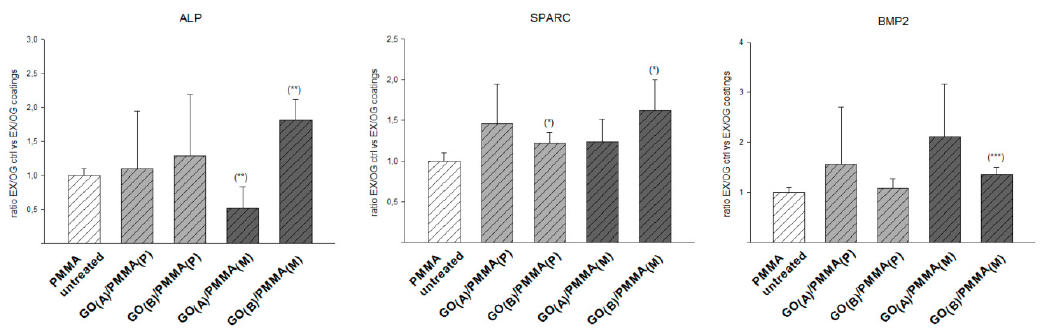
Figure 6. The expression of specific osteogenic markers (ALP, SPARC, and BMP-2) of hMSPCs cultured for 21 days on the surface of GO/PMMA composites with respect to a PMMA control; p < 0.001 ***; p < 0.01 **; p < 0.05 *.